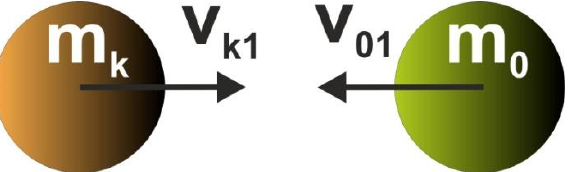
Figure 4. A neighboring body (k) collides with the central one (0). Before collision.